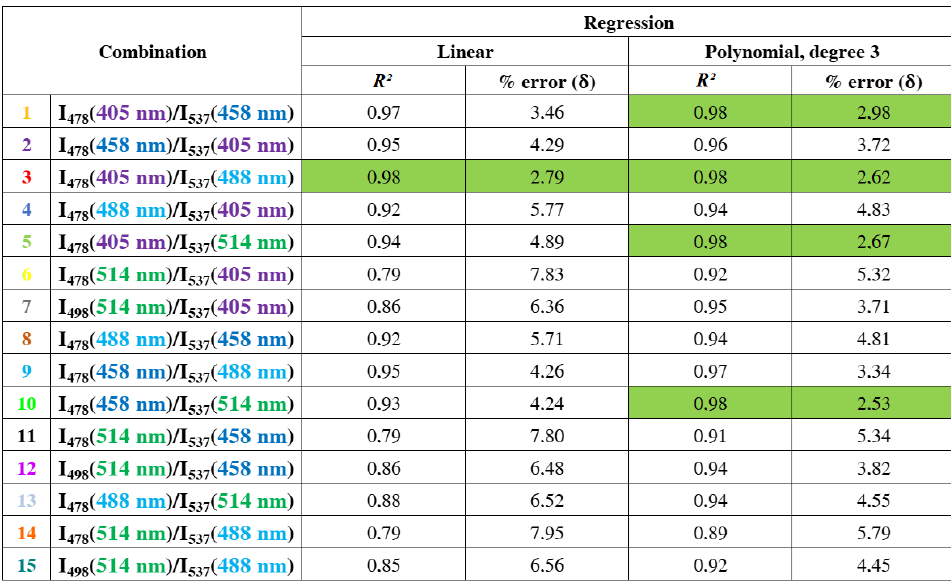
Figure 8. The coefficient of determination R 2 and the percent error δ for each regression applied on the data points of each laser combination. In green, the 4 best combinations with a coefficient of determination R 2 of 0.98 and a percent error smaller than 3%.